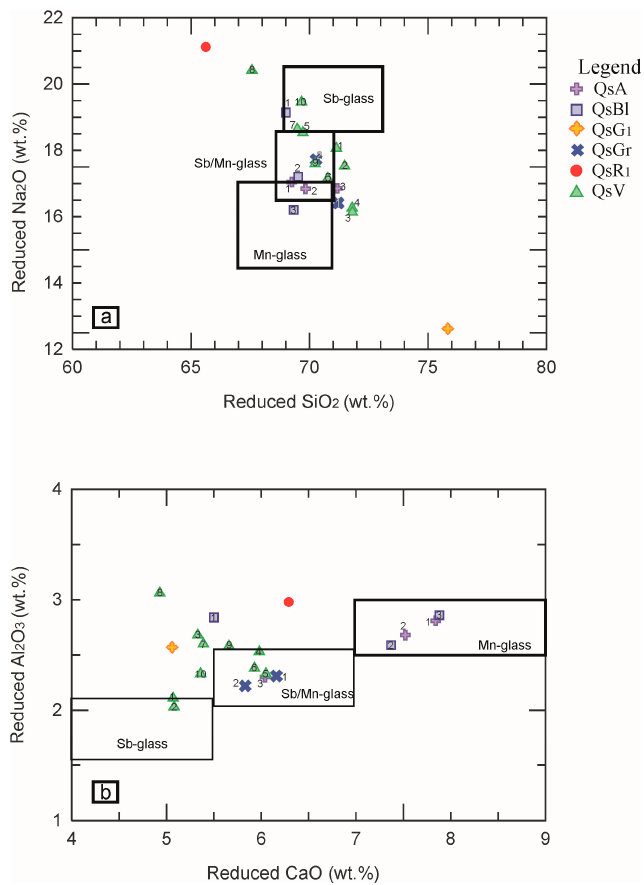
Figure 4. Binary diagrams ( a ) reduced-SiO 2 vs. reduced-Na 2 O; ( b ) reduced-Al 2 O 3 vs. reduced-CaO. The coloured symbols in the legend refer to the various types of tesserae, while the numbers inside the symbols in the diagrams are associated with the individual sample analysed. The majority of the samples, despite the great geochemical variability, plots near the area of Sb/Mn glass, except for four samples QsA1, QsA2, QsBl2 and QsBl3, which match the Mn-glass. Green sample QsV8, yellow QsG1 and red QsR1 do not fit the Roman compositional groups. Indeed, the yellow tessera in the reduced composition shows a very low content of Na 2 O (= 12.62 wt.%) and a high content of SiO 2 (around 76 wt.%) (Table 3). On the contrary, the green QsV8 and the QsR1 red glasses display higher alumina and soda and lower silica contents. As concerns the yellow tessera (QsG1), the chemical characteristics (Table 3) make it possible to hypothesise that the sample is influenced by a superficial alteration with a consequent de-alkalinisation [35–37].